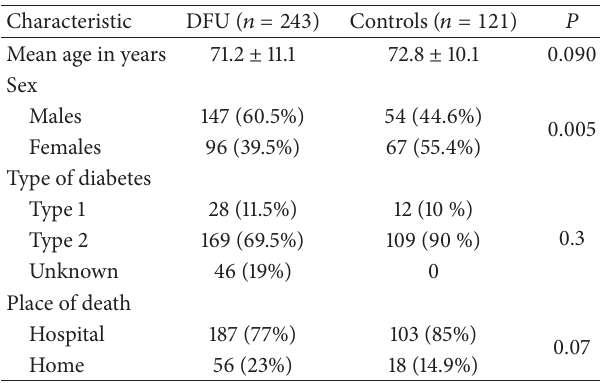
Table 1: Characteristics of diabetic foot ulcer patients and